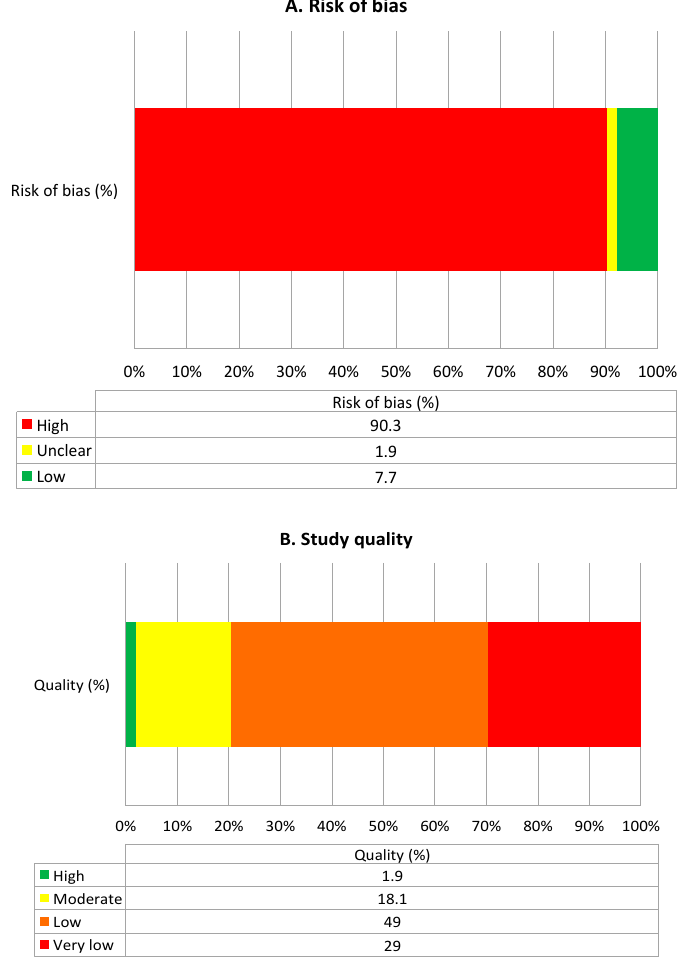
Figure 3. Summary of quality and bias, as assessed using the Grading Recommendations Assessment and Development Evidence (GRADE) method [4]. ( A ) Summarises risk of bias and ( B ) summarises quality of included studies.